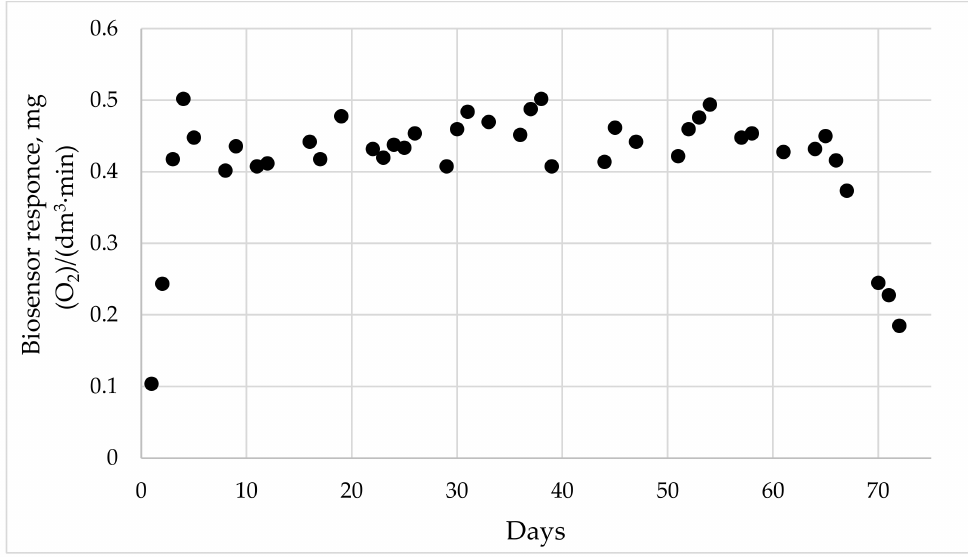
Figure 9. Diagram of long-term stability of